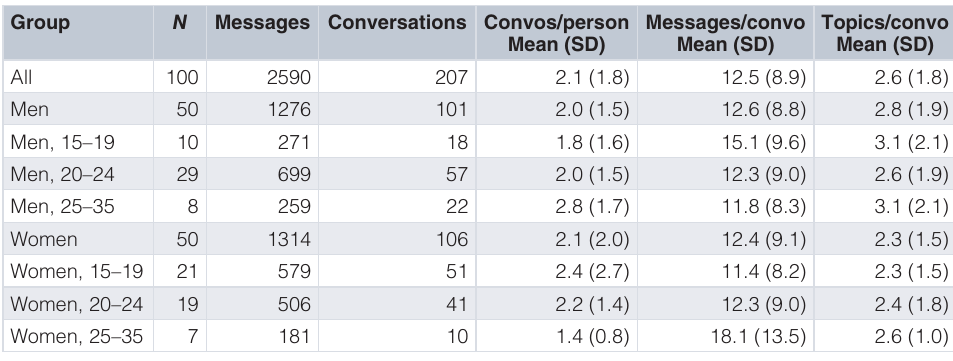
Table 2. Characteristics of conversations.